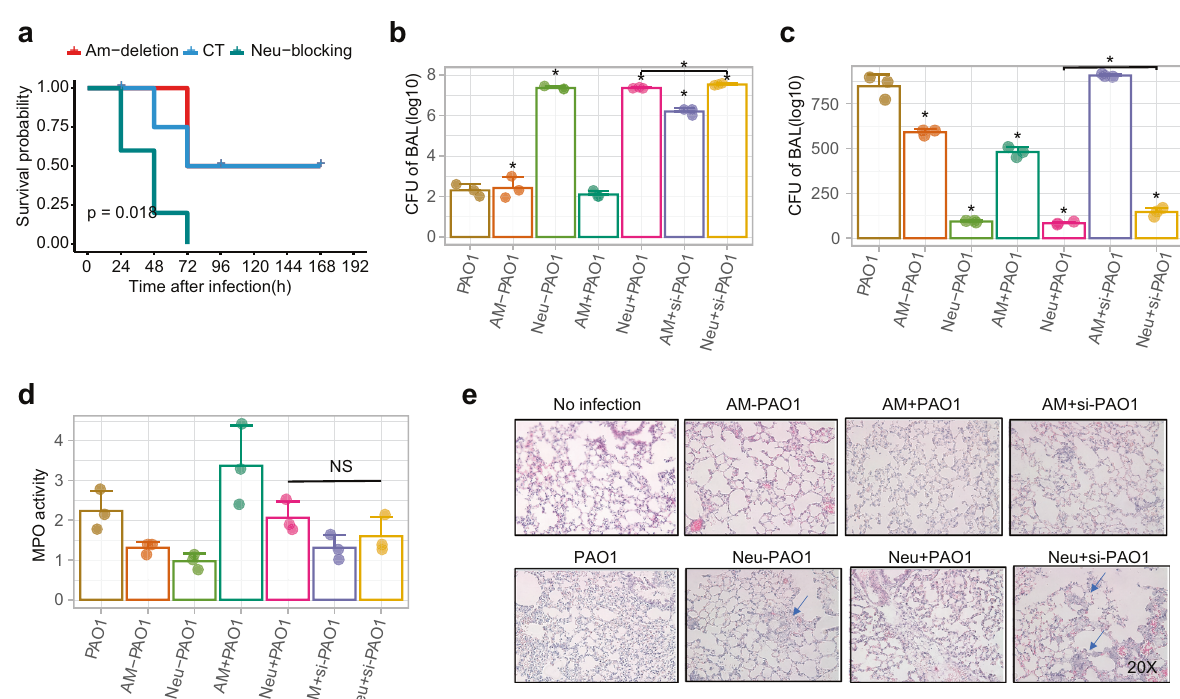
Fig. 6 Tas2r138 played protective roles against P. aeruginosa infection in vivo. a Eight to 12 weeks male and female (sex-matched) mice were subjected to neutrophil depletion by injecting (i.p.) 0.1 mg GR-1 monoclonal antibody with rat IgG as control at 24 or 48 h before bacterial infection. AMs were depleted by i.n. instillation of 100 µl of clodronate-containing 48 h before infection with 1 × 10 7 PAO1. 44 Mouse survival was monitored for 7 days. Survival was represented by Kaplan – Meier curves. ( p = 0.0273, n = 6, log-rank test). b , c After AMs and neutrophils depletion, 1 × 10 6 normal or siTas2r138 AMs or siTas2r138 neutrophils were transferred by I.V. injection. d , e CFU and total cells test in BAL (B blocking, D depletion), MPO test, cytokines test (from serum), and histochemical staining were performed after 24 h post infection and euthanasia mice (blue arrows showing the 10× augmented view for indicated areas). The results were expressed as the mean ± SD and the signi fi cant difference level between two groups was de fi ned by student t tests, * p < 0.05. AM − AM cell deletion, AM + AM cell deletion and then transferred AM back, AM + si AM cell deletion and then transferred siTas2r138 AM back, Neu − Neu blocking, Neu + Neu blocking and then transferred Neu back, Neu + si Neu blocking and then transferred siTas2r138 Neu